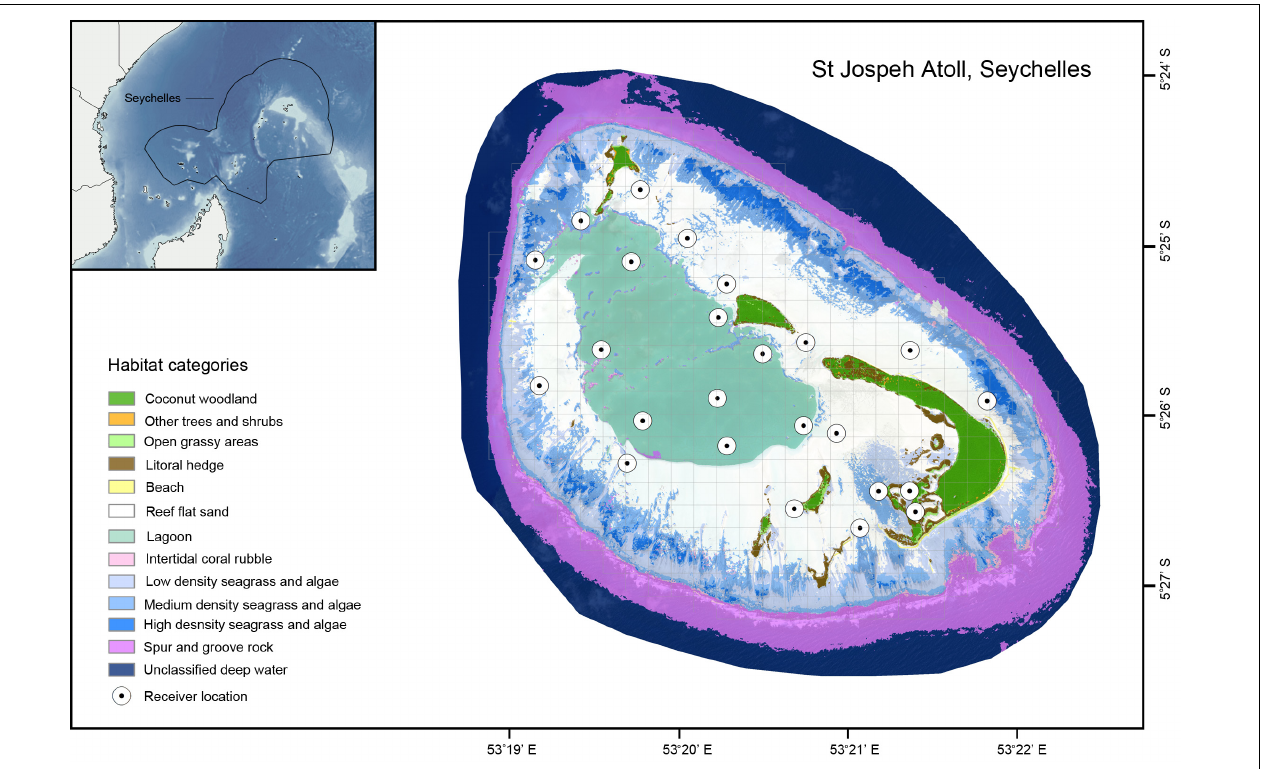
FIGURE 1 | Habitat map of St Joseph Atoll. Gray gridlines depict the 0.25 km 2 grid cells used for occupancy analysis. Habitat data created by n + p biologists (www.nplusp.ch) using supervised image classification of 2 m 8 band MS 16-bit orthorectified WorldView-2 high-resolution satellite images from LAND INFO Worldwide Mapping, LLC (Denver, CO, United States) and is Copyright Save Our Seas Foundation. The map was produced using ArcGIS (ESRI Inc., CA, United States), with the bathymetry data in the inset obtained from the United States Department of Commerce, National Oceanic and Atmospheric Administration (NOAA): 2-minute Gridded Global Relief Data